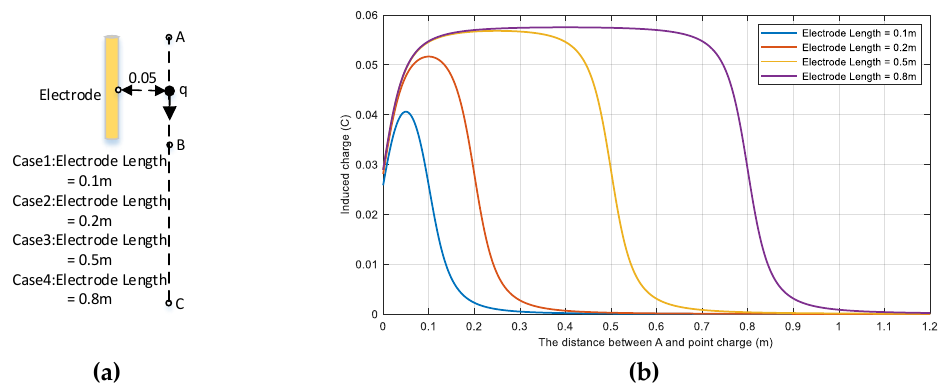
Figure 9. The point charge moves in a direction parallel to the axis of the electrode: ( a ) State of moving the point charge parallel to the electrode; and ( b ) amount of charge induced by moving the point charge parallel to the electrode.